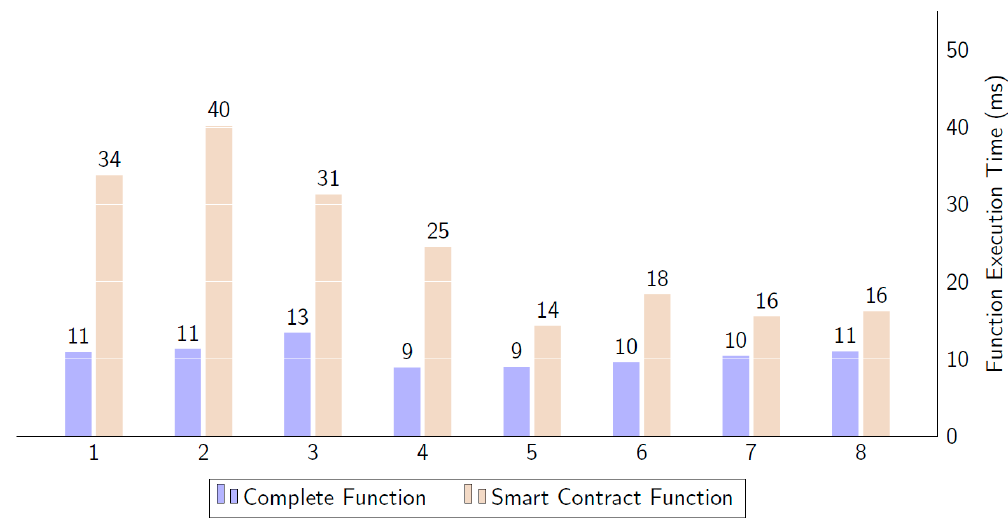
Figure 11. The time required to execute a function and keep the data in IPFS and Blockchain.